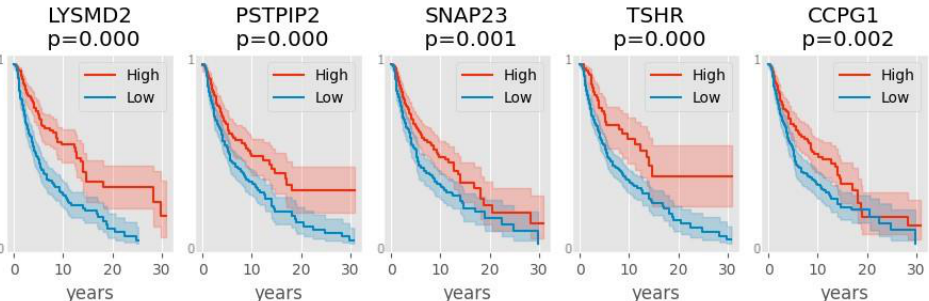
Figure 4. Kaplan-Meier plots showing that the blue lines (low expressor) fall faster than the red lines (high expressors) for each gene. The y-axis represents the probability of survival, thus, high expressors of these five genes have better survival. In this analysis, the patient samples were divided in terms of the average of gene expression (high = above the mean, low = below the mean).